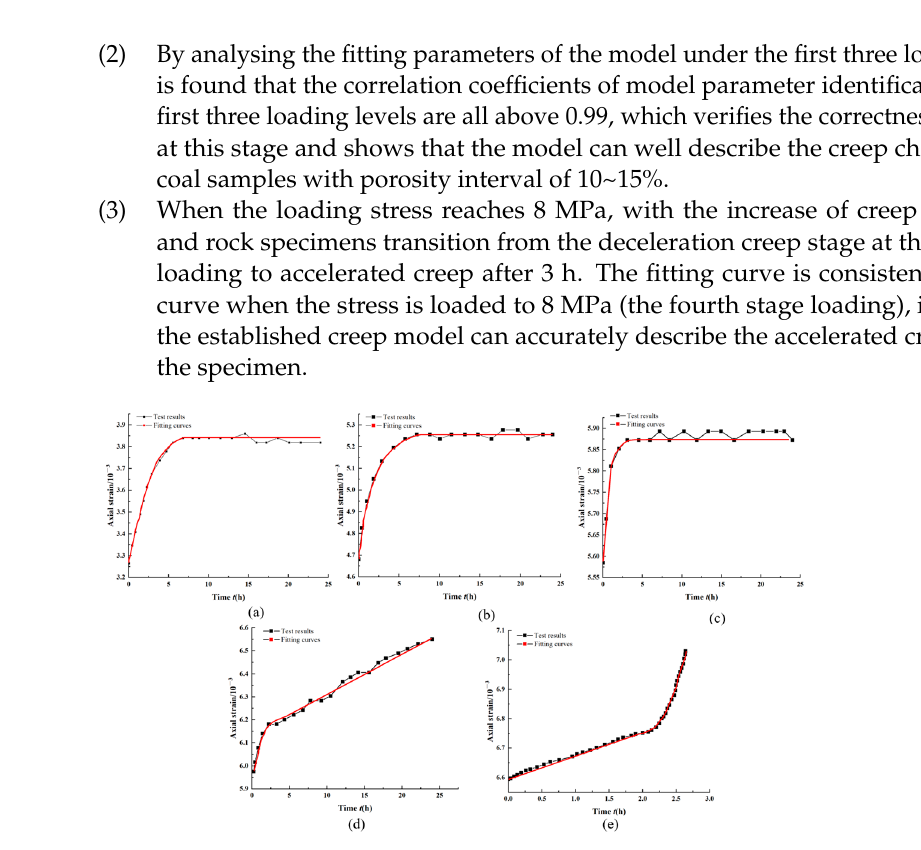
Figure 18. Fitting curves of 10–15% in each stage of pore interval. (a) First stage; (b) Second stage; (c) Third stage; (d) Fourth stage; (e) Fifth stage.